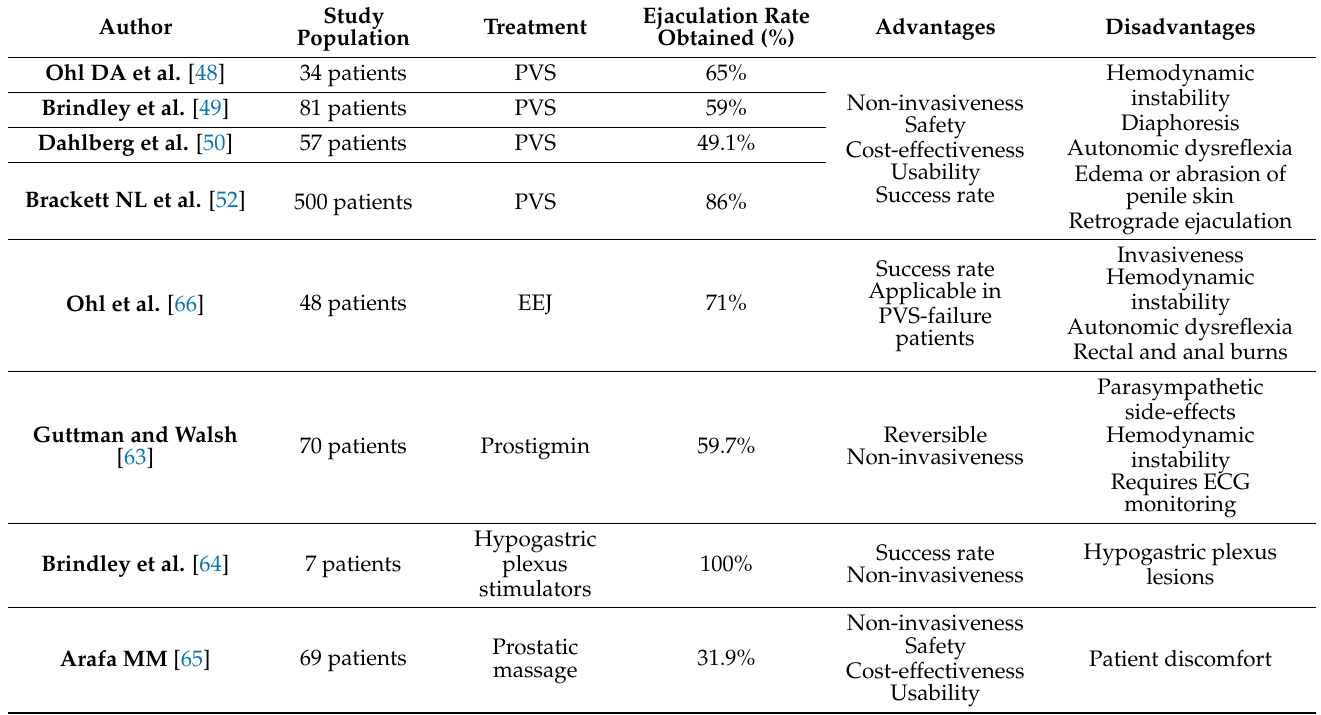
Table 3. Main findings relative to the management of male ejaculatory disorders in SCI patients. The main outcome was the ejaculation rate obtained in SCI patients using several different ap- proaches: PVS, EEJ, subcutaneous physostigmine, intrathecal neostigmine, the direct stimulation of the hypogastric nerve, and prostate